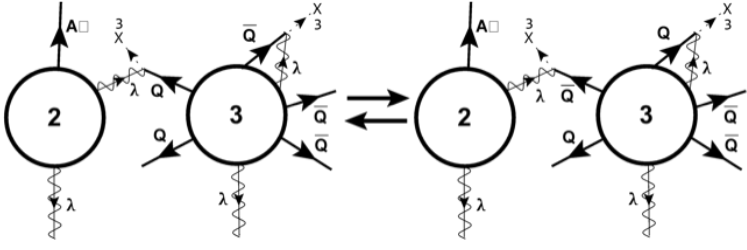
Figure 12: A sketch of multi-monopole composite with + 2 + 3 when M is large. The gauge group breaks from SU ( 5 ) to SU ( 4 ) . Two “resonance" diagrams equivalently form the 2 + 3 composite. The anti-symmetric and squark VEVs, (C.3) and (C.4), are represented as X with their indices. A □ represents the components of anti-symmetric tensor which transform as a fundamental representation under the unbroken SU ( 4 )